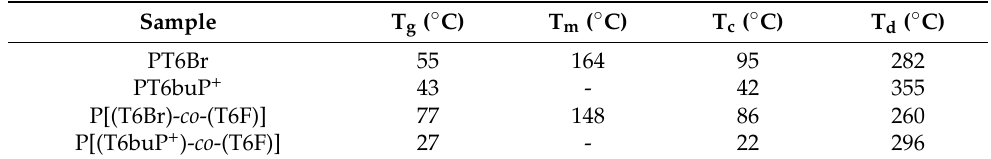
Table 3. Glass-transition (T g ), melting (T m ), crystallization (T c ) and initial decomposition (T d ) temperatures of